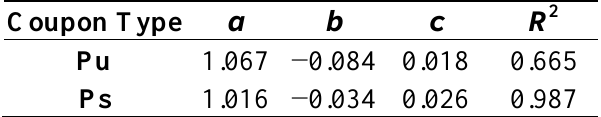
to Vv correlation (Figure 6). N N